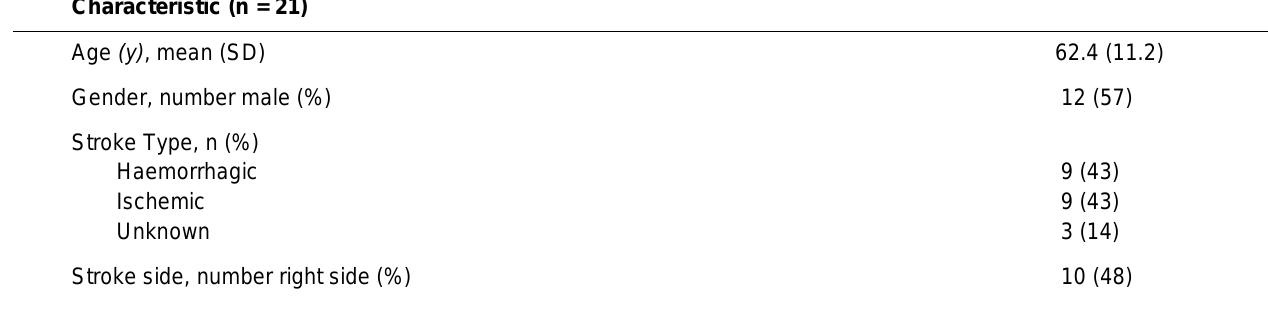
Table 2. Characteristics of Participants who Completed 8 Weeks of Exercise Training (n=21) Characteristic (n =